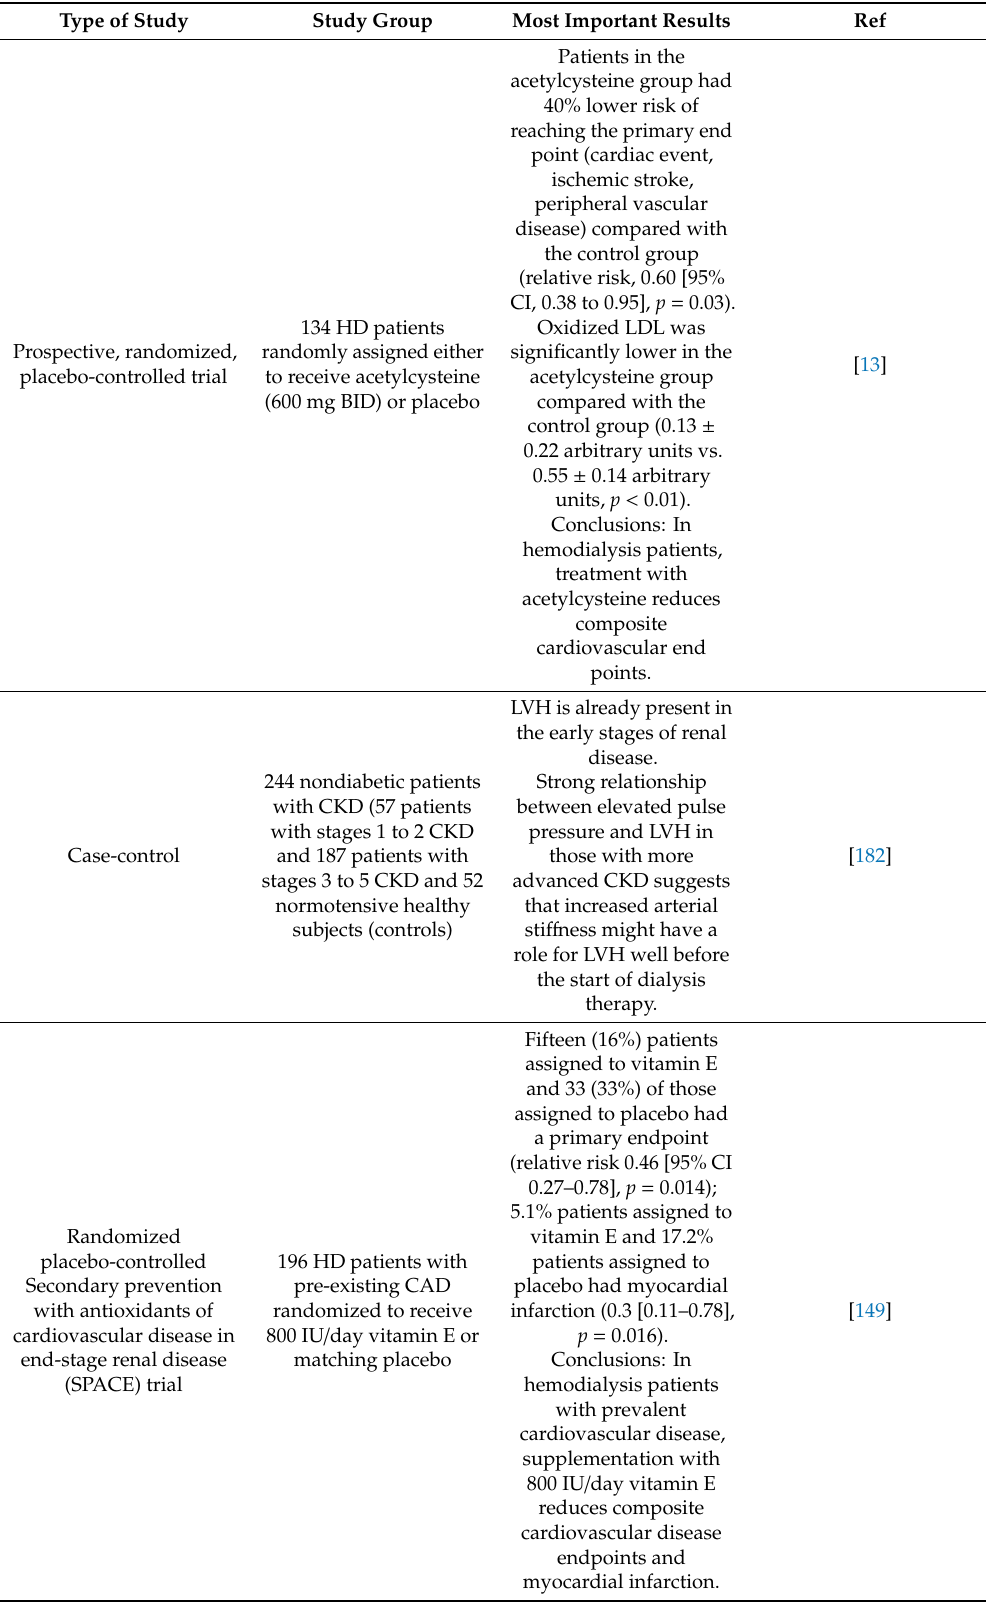
Table 1. The results of selected articles concerning the adverse impact of oxidative stress. Type of